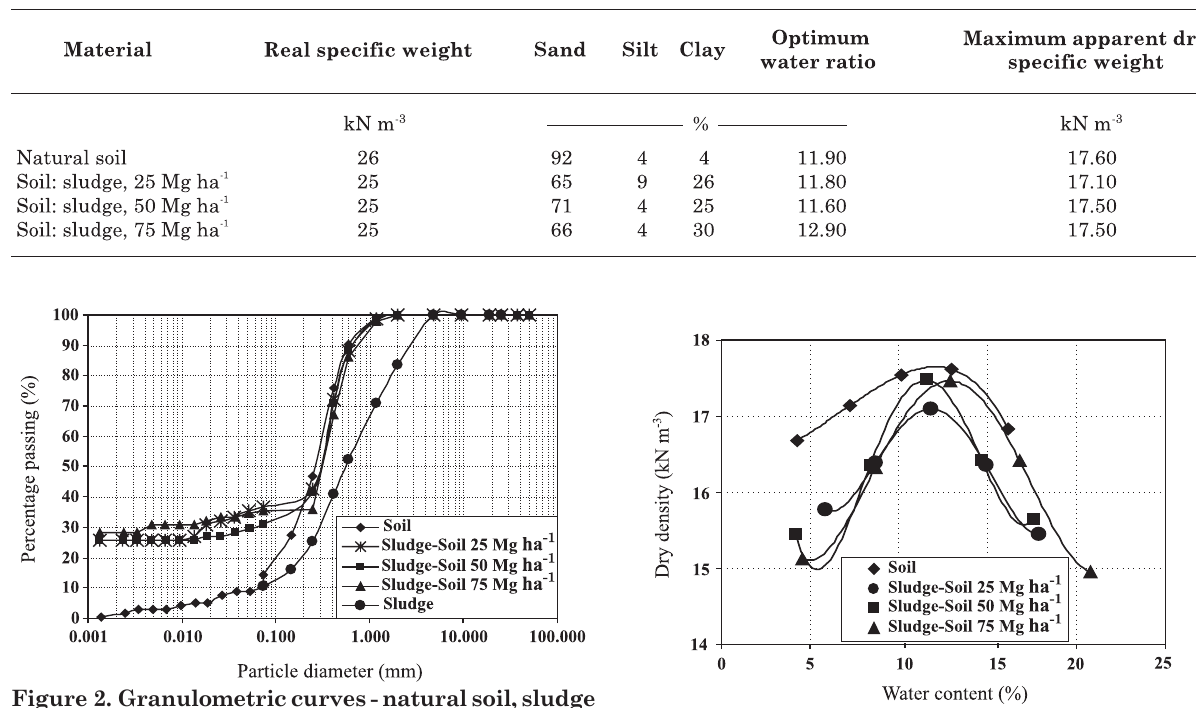
Figure 3. Compression curves - natural soil